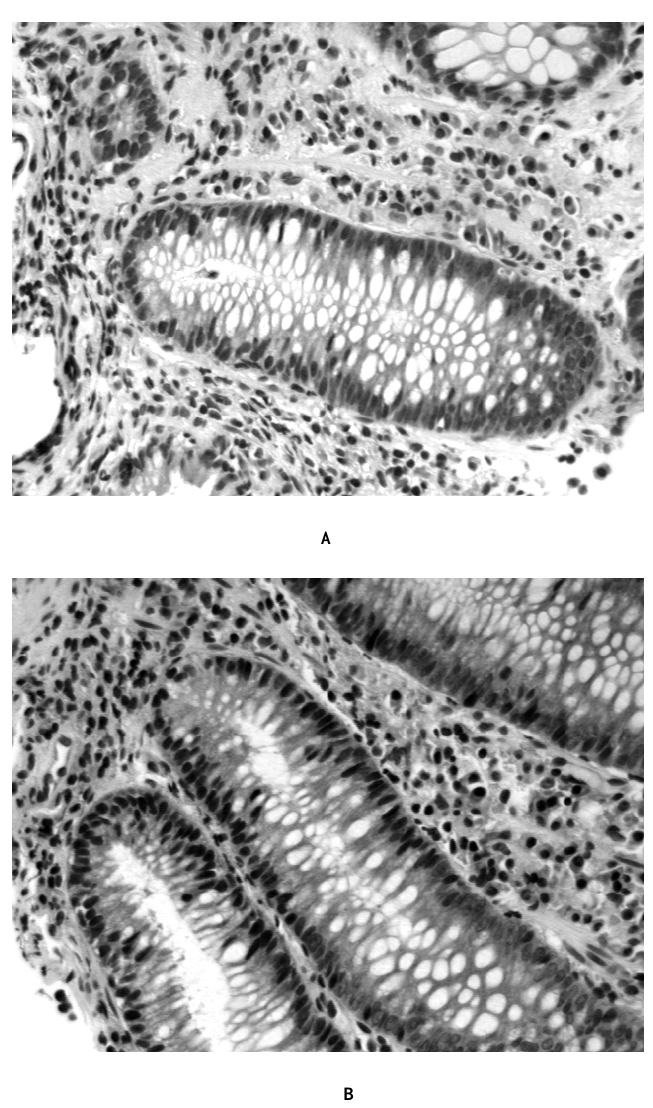
FIGURE 6. Two additional intestinal cell gland